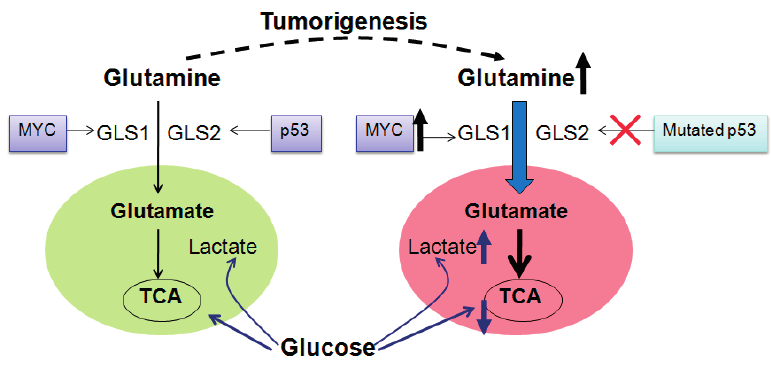
Figure 2. Glutamine consumption is increased in most tumors. During tumorigenesis, glucose derived lactate is increased, and at the same time, contribution of glucose to TCA is decreased. Accompanied with glucose metabolism change, glutamine metabolism is up-regulated to compensate energy and macromolecular for cell proliferation and growth. p53 is mutated, while MYC is overexpressed, which promotes glutamine metabolism by upregulating GLS1 activity during tumorigenesis. GLS1 is highly expressed in many tumors and promotes tumor proliferation. In contrast, GLS2 expression is reduced in some tumors. GLS, glutaminase; TCA, tricarboxylic acid cycle. Bold arrow, increased glutamine metabolism, decreased glucose metabolism and mutated MYC ; dashed line, tumorigenesis